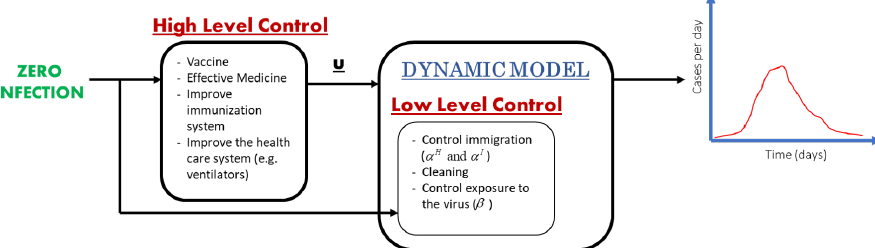
Figure 12. Low level and high level control structure considered in this